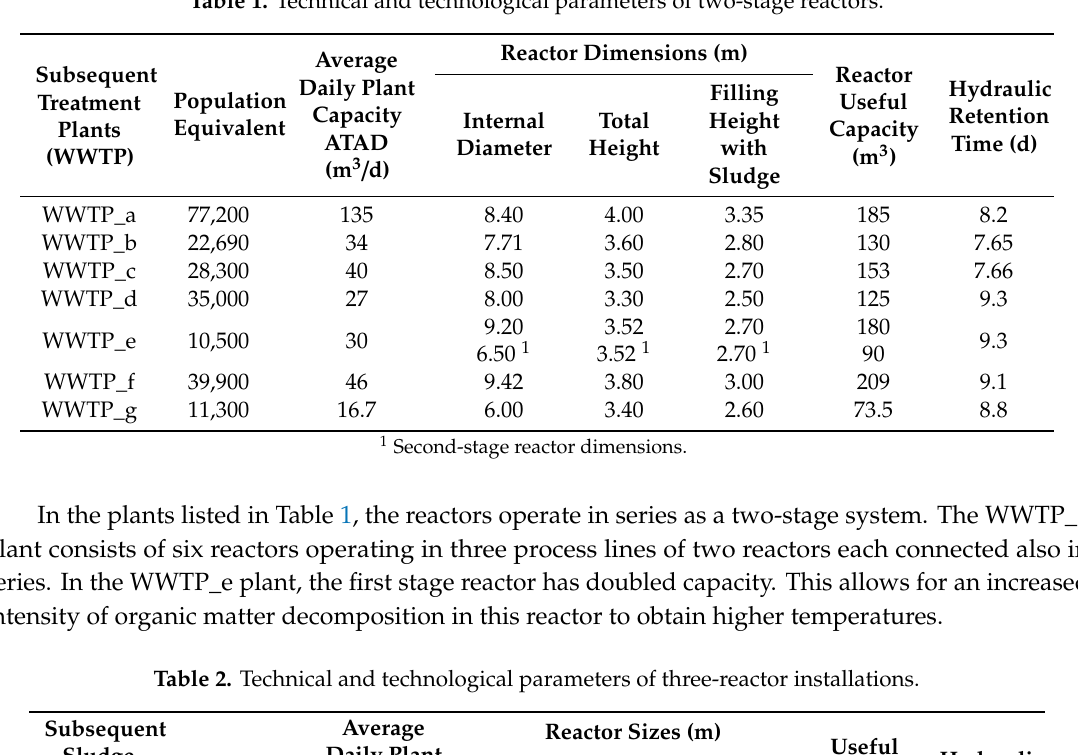
Table 1. Technical and technological parameters of two-stage reactors.